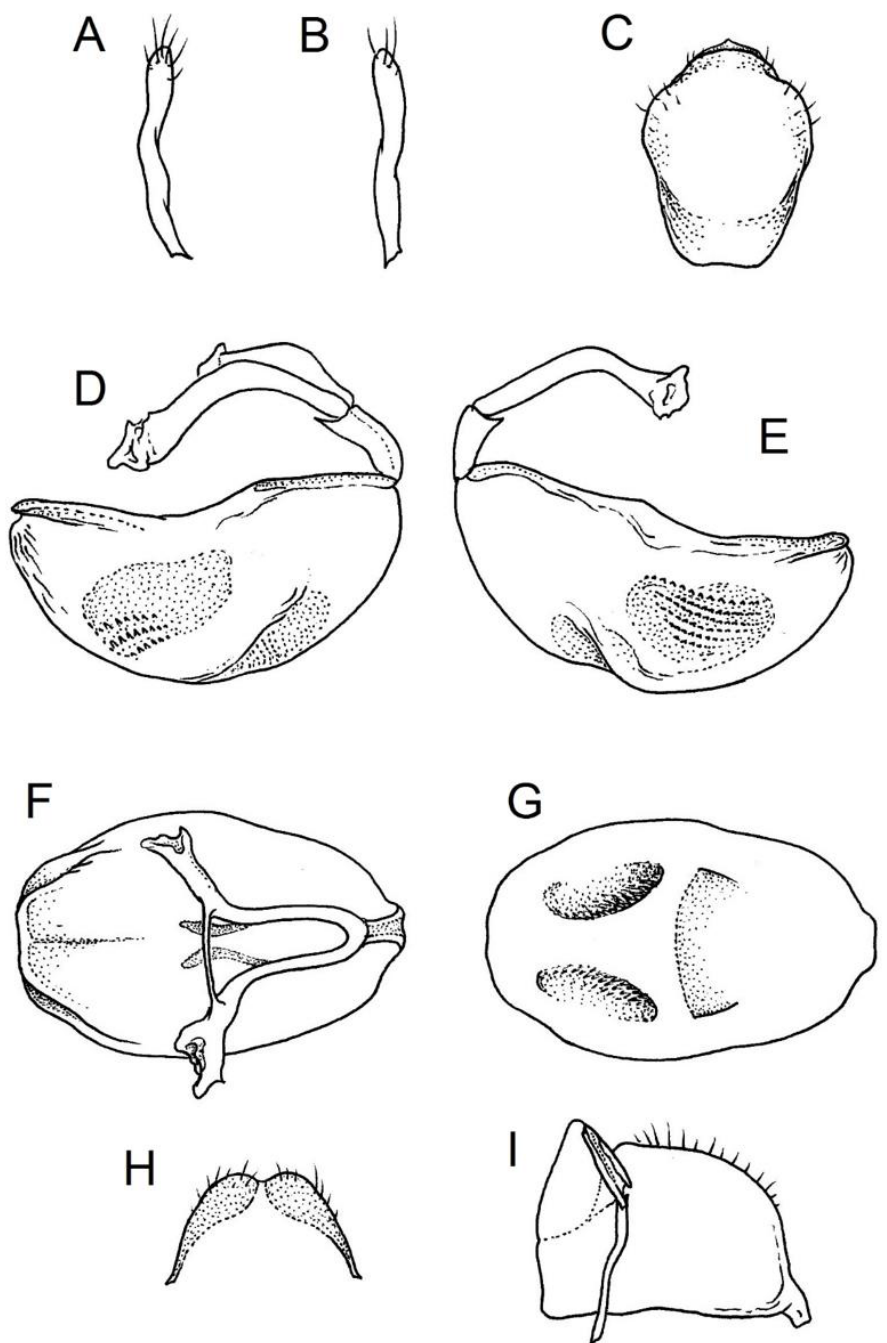
Figure 40. Phonoctonus fasciatus (Beauvois, 1805): ( A ) left paramere; ( B ) right paramere; ( C ) pygophore, ventral view; ( D ) aedeagus, right lateral view; ( E ) aedeagus, left lateral view; ( F ) aedeagus, dorsal view; ( G ) aedeagus, ventral view; ( H ) styloids, outer view; and ( I ) gonocoxite of abdominal segment VIII. Reduvius fasciatus Beauvois, 1805: 65. Holotype ( ): ♂